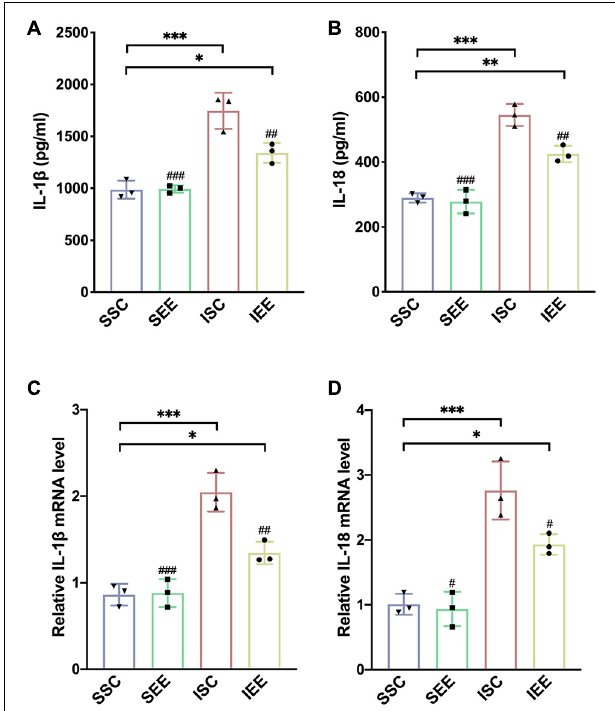
FIGURE 5 | Enriched environment suppressed the expression levels of inflammatory cytokines in the penumbra. (A,B) Effects of EE treatment on IL-1 β and IL-18 expression in penumbra according to ELISA. n = 3. (C,D) Quantitative analysis of IL-1 β and IL-18 mRNA levels in penumbra. n = 3. Data are expressed as mean ± SD. * p < 0.05, ** p < 0.01, *** p < 0.001 vs. SSC group; # p < 0.05, ## p < 0.01, ### p < 0.001 vs. ISC